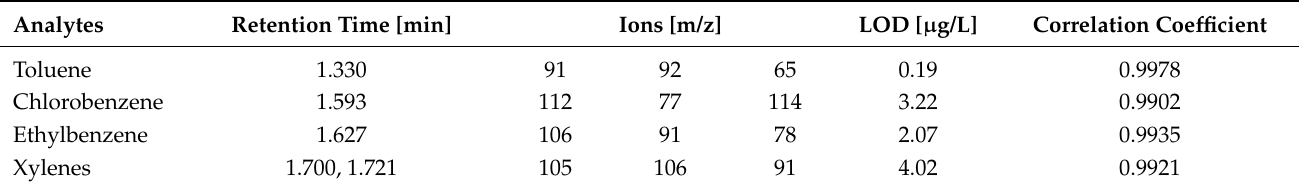
Table 1. The retention times of the identified compounds, the selected fragment ions (m/z), and basic validation parameters.